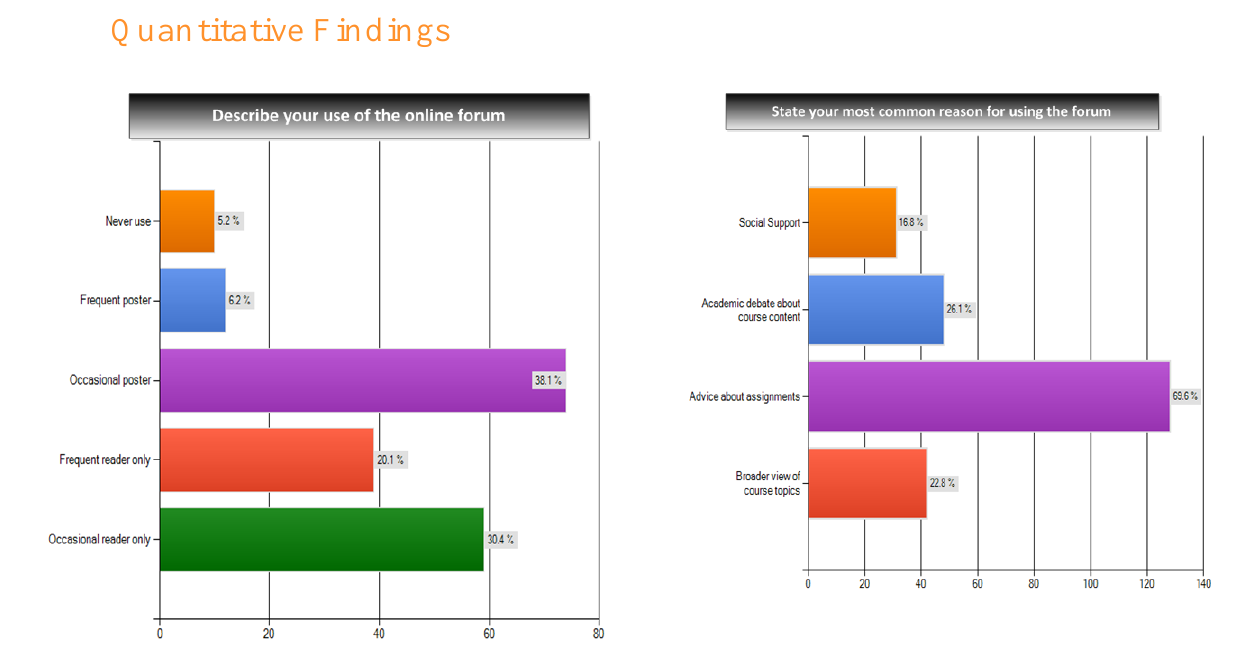
Figure 4 . Use of online